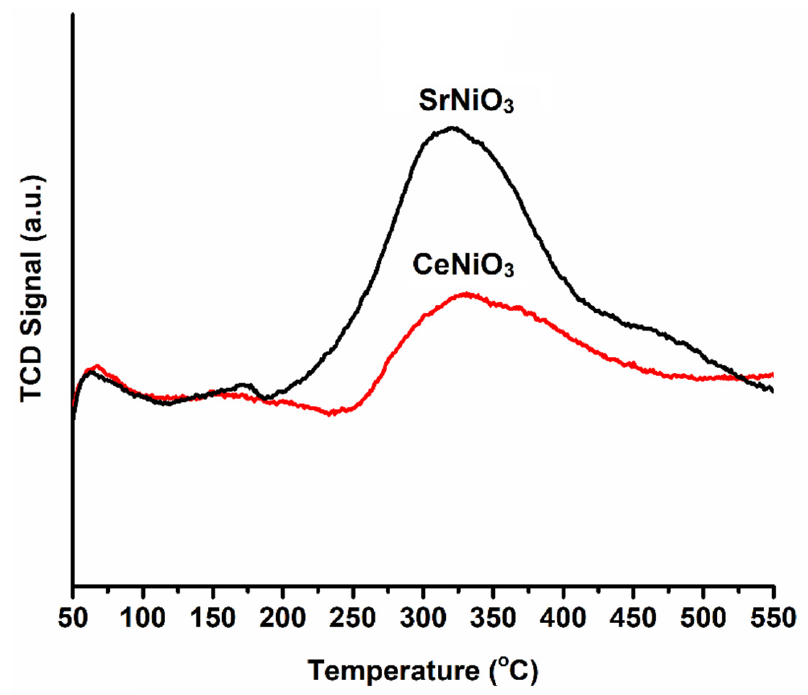
Figure 6. TPO profiles of SNiO 3 and CeNiO 3 perovskites.